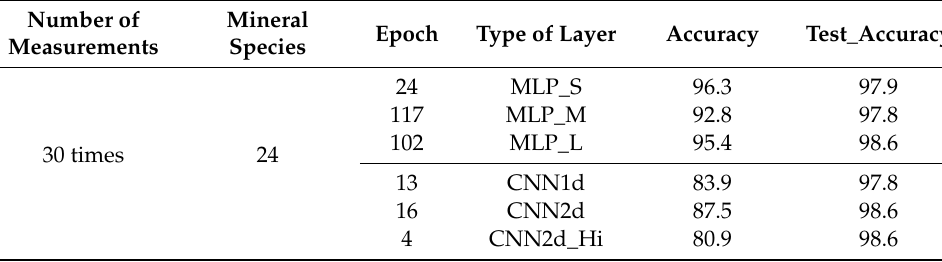
Figure 17. Accuracies and loss function values of CNN2d_Hi_HQ.